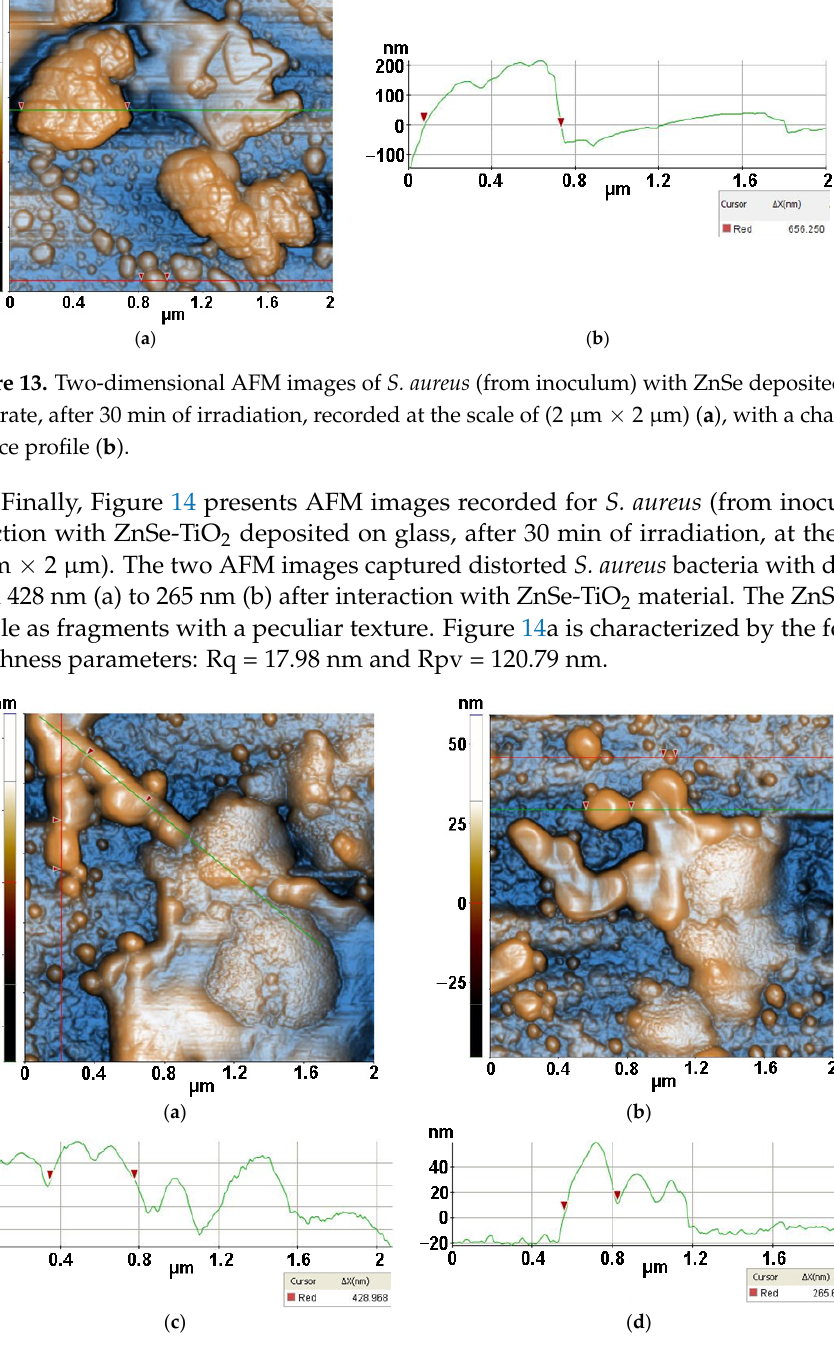
Figure 12. Two-dimensional AFM images of S. aureus (from inoculum) with TiO 2 deposited on glass substrate, after 30 min of irradiation, recorded at the scale of (2 μ m × 2 μ m) in two different areas ( a , b ), with two characteristic surface profiles for each image in red ( c ) and green ( d ).